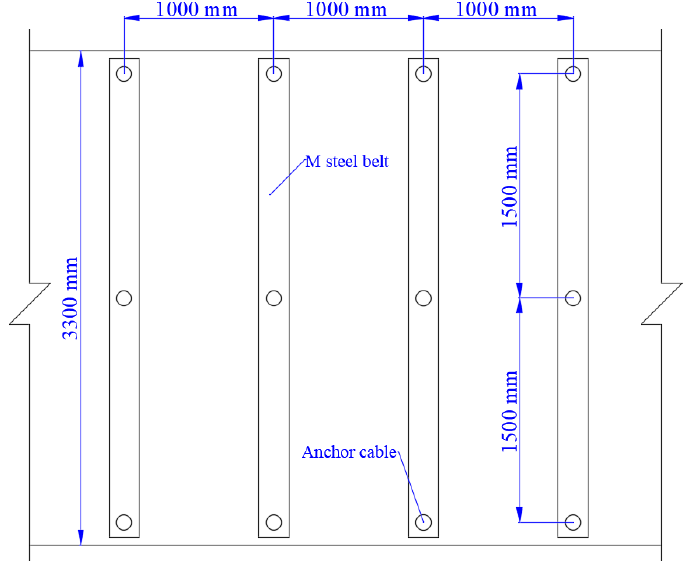
Figure 10. Bottom view of M-tape arrangement.